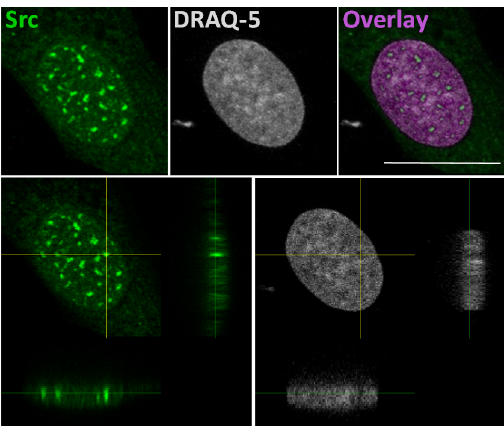
Figure 2. In the upper panels: representative confocal microscope images of immunofluorescent staining for Src (left panel), nuclear dye DRAQ-5 (middle panel) and the overlay fluorescence (right panel - pseudo-colored in purple) of detailed nuclei of human osteosarcoma cell line SaOS2. Scale bar: 20 µ m. In the lower panels: confocal microscope average XYZ projection of a stack of images of Src (left panel) and DRAQ-5 (right panel) fluorescences. The yellow cross-section pinpoints the location for the YZ and XZ axes